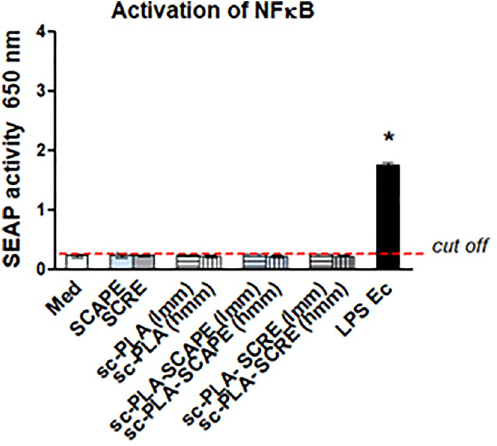
Figure 3. Activation of nuclear factor kappa B (NF-κB) in THP1-XBlue monocytes. Med-medium; SCAPE— S. cadmica aerial part extract; SCRE— S. cadmica root extract; sc-PLA (lmm) and sc-PLA (hmm)—sterocomplexed microparticles with low molecular mass or high molecular mass, respectively, unloaded or loaded with S. cadmica extracts; LPS Ec—lipopolysaccharide Escherichia coli . SEAP—secretory embryonic alkaline phosphatase. *The difference statistically significant; p < 0.05; LPS Ec vs . Med.